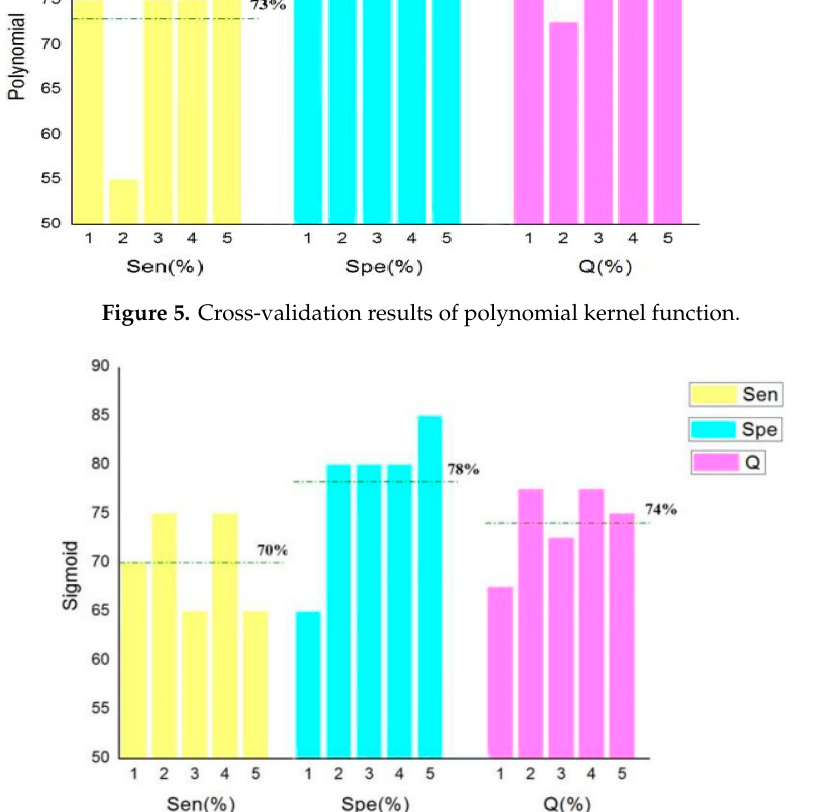
Figure 6. Cross-validation results of sigmoid kernel